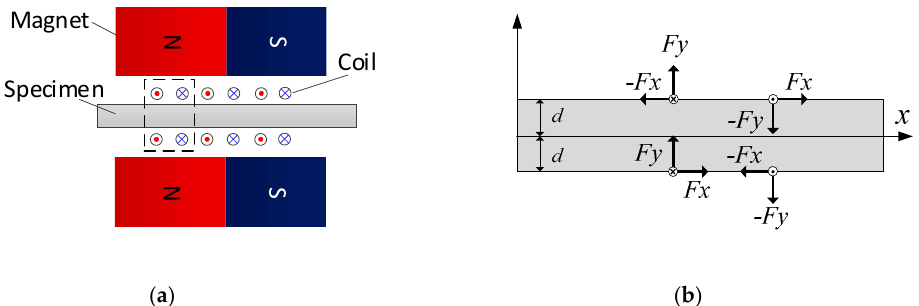
Figure 5. ( a ) The paired parallel biased EMAT (PB-EMAT) configuration, and ( b ) the Lorentz forces generated by the paired PB-EMAT. Only the Lorentz forces generated by the wires in the dotted frame are plotted in ( b ) too. The meanings of symbol ○ × and ○ ▪ are the same as in Figure 4.